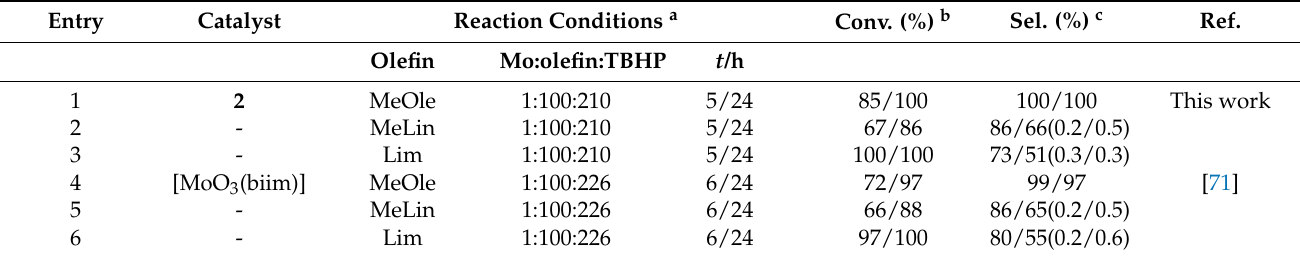
Table 2. Catalytic results for 2 and [MoO 3 (biim)] in the epoxidation of bio-derived